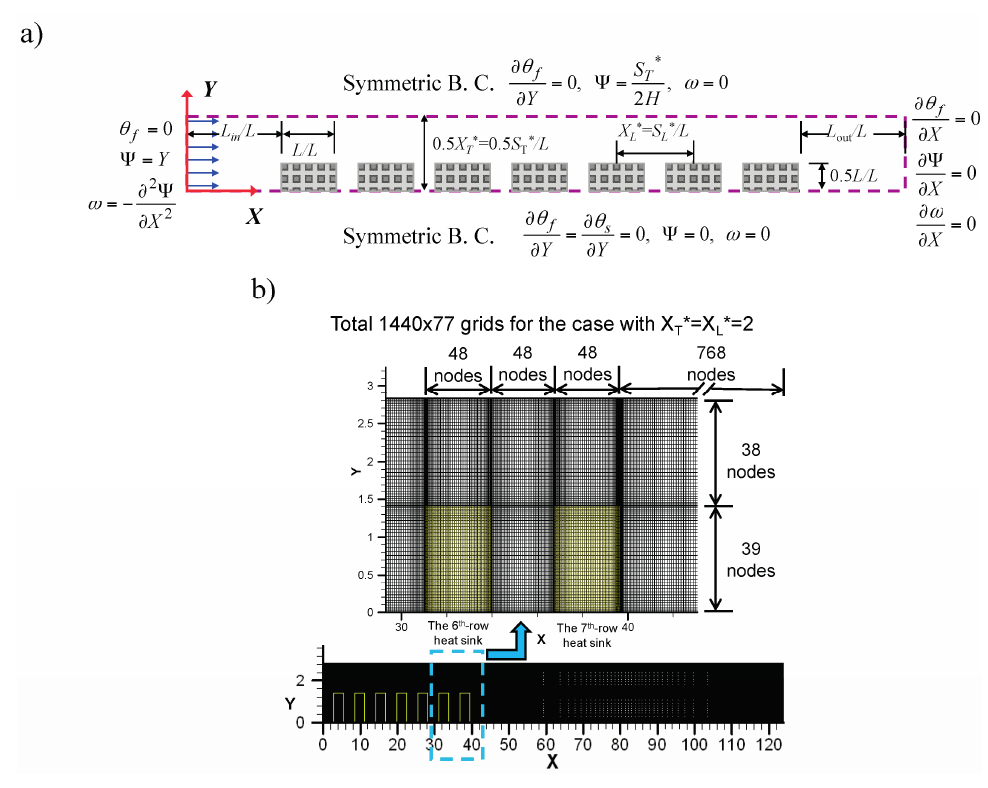
Figure 3. Computational configuration (the direction of pin fins is pointing the Z -axis vertical to paper surface): ( a ) boundary conditions and ( b ) mesh (the scales of X -axis and Y -axis are